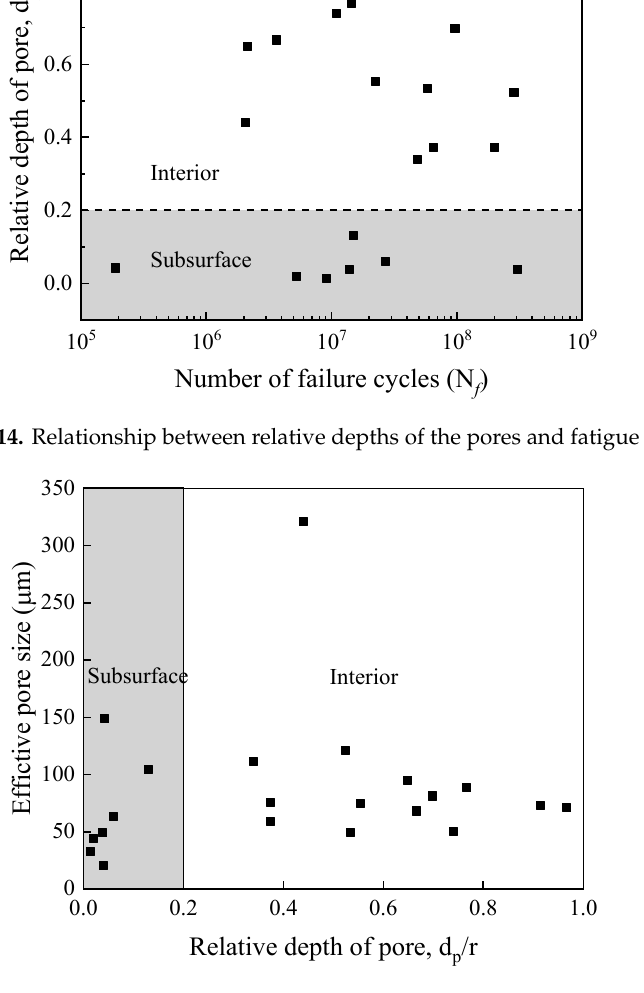
Figure 15. Relationship between pores sizes and relative pores depths.